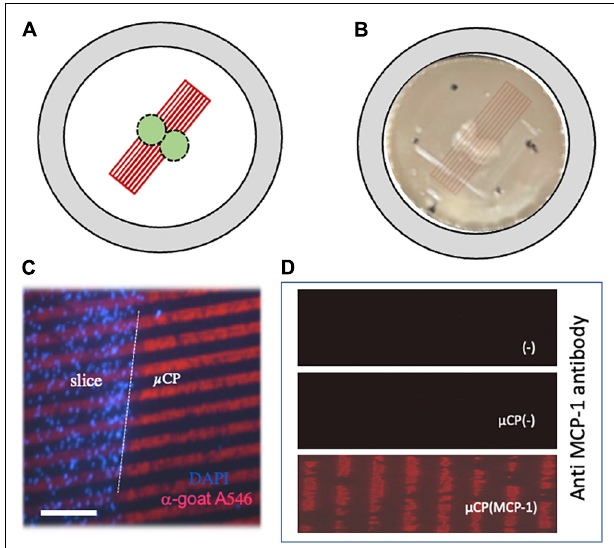
FIGURE 1 | Characterization of microcontact printing. Panel (A) shows a scheme, how two organotypic cortex “chopper” brain slices (300 µ m) were connected to microcontact prints ( µ CP). Panel (B) shows the two brain slices on a semipermeable membrane and how the µ CP are coupled (artificial overlay, which is not visible by eye). The dots mark the orientation to link the slices. Panel (C) shows a merged picture where brain slices were cultured for 3 weeks, then fixed and stained for nuclear DAPI (blue fluorescent). The slices were connected to a loading control using red fluorescent (anti-goat Alexa-546) µ CP lanes. The white dotted line in panel (C) indicates the border of the brain slice. Immunostainings against monocyte chemoattractant-protein-1 (MCP-1) shows that MCP-1 was printed onto the membranes [Panel (D) , lower panel], compared to negative controls without µ CP [Panel (D) , upper panel] and µ CP with collagen only [Panel (D) , middle panel]. Scale bar in panel (C) = 500 µ m (B) , 190 µ m (C) , 110 µ m (D) .